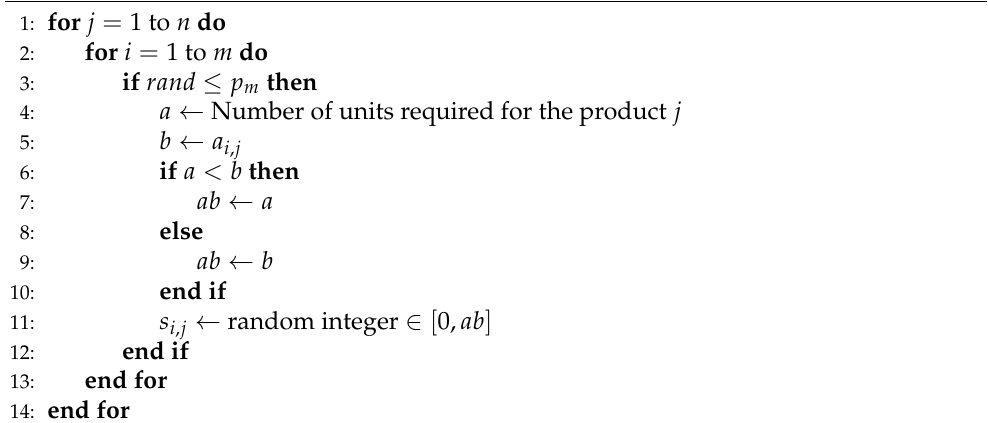
Algorithm 3 Proposed mutation operator for the ISHOP with item